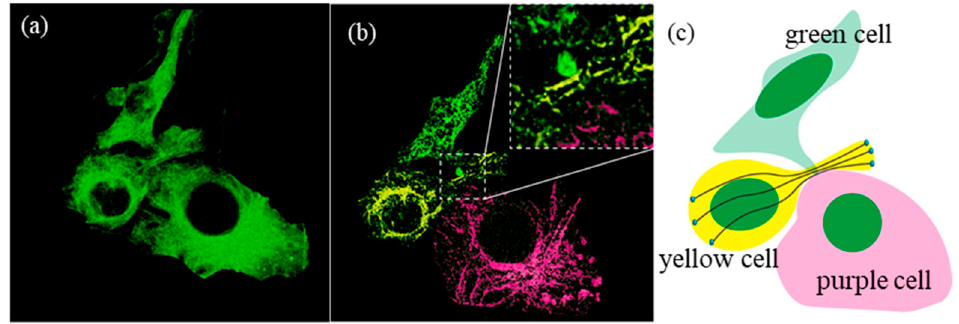
Figure 13. Schematic of cell collision and crossing through the 3D reconstruction of the images. ( a ) 3D reconstruction from the original images, ( b ) 3D reconstruction from the processed images, and ( c ) schematic of the relationship between the three cells.